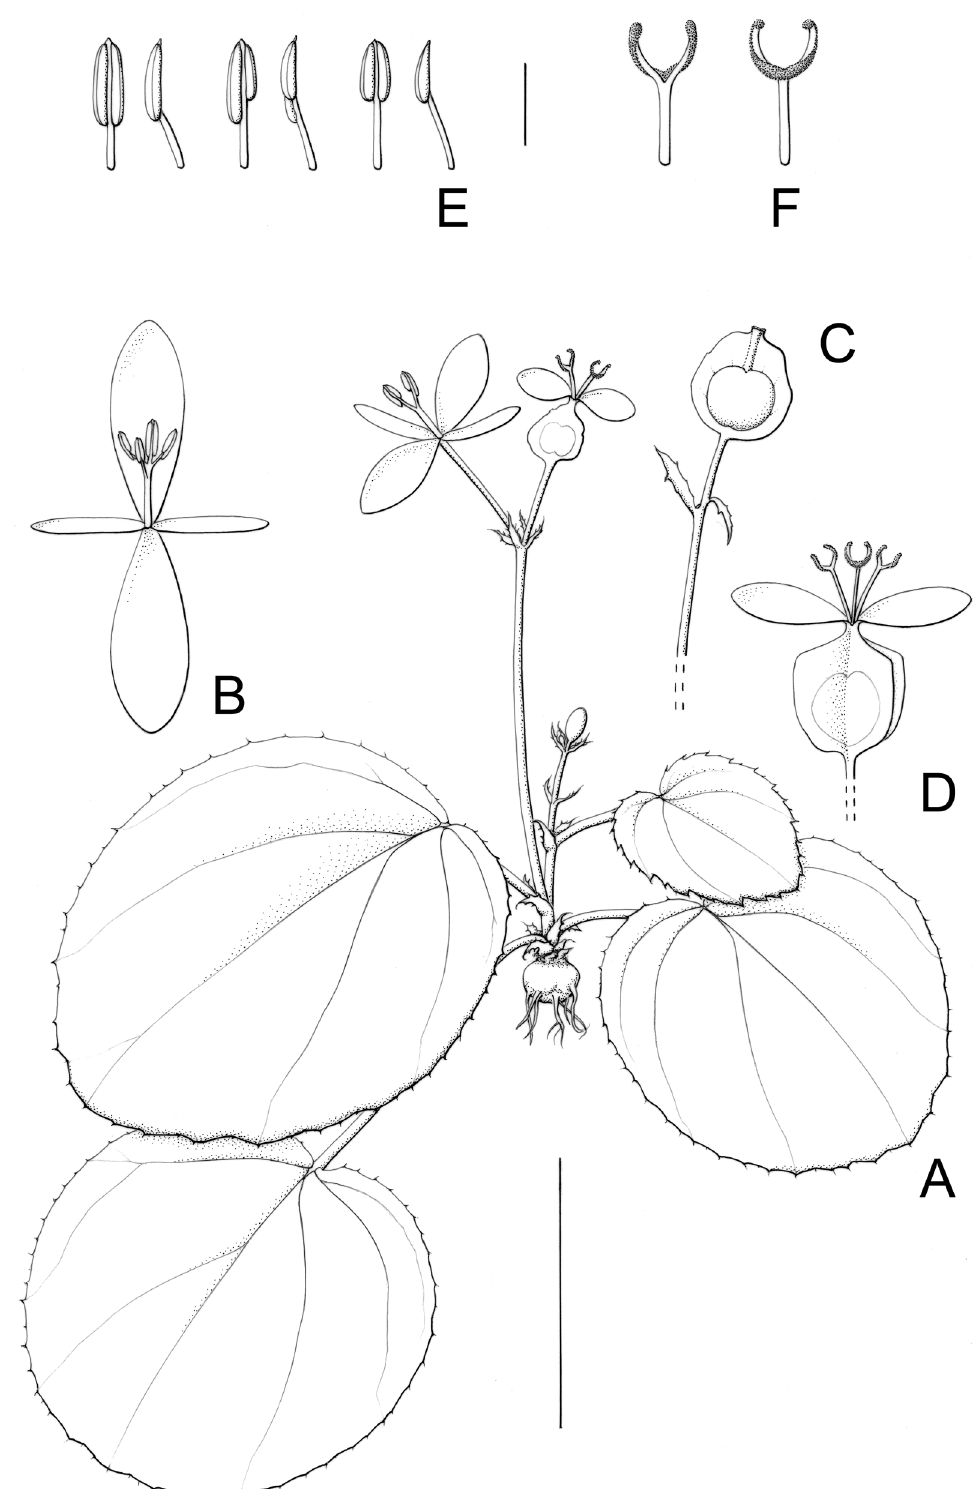
Fig 2. Begonia elachista Moonlight & Tebbitt sp. nov. A . Habit. B . Male flower, front view. C . Branch of infructescence. D . Female flower, side view. E . Stamens, front and side view. F . Style, front and back view. Scale bars: A–D = 1 cm; E–F = 1 mm. Drawn by Claire Banks. From P. Moonlight & A. Daza 318